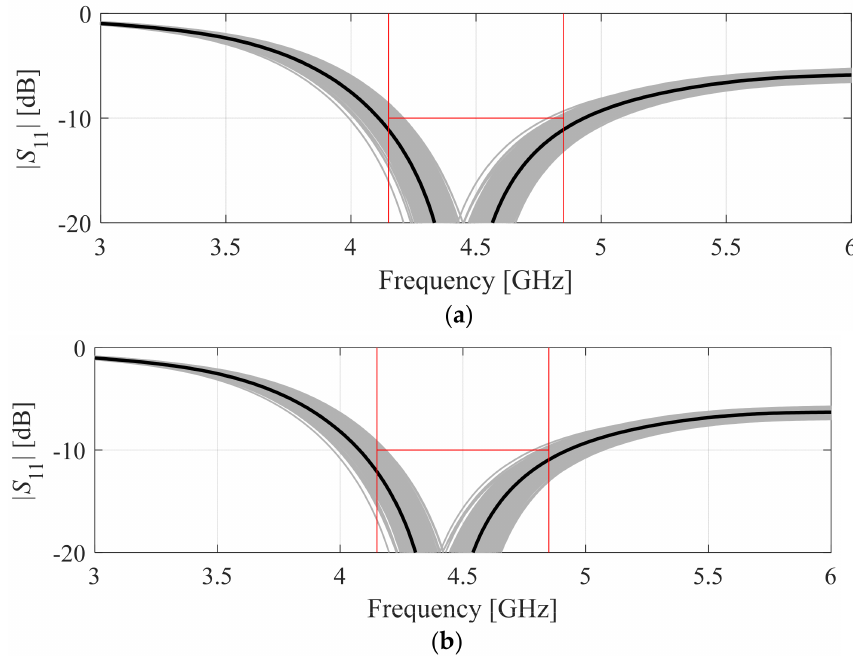
Figure 9. Monte Carlo analysis of antenna of Figure 7 using EM simulations (gray plots): ( a ) nominal design; ( b ) yield-optimized design obtained using the algorithm of Section 3.1. Black plots show the antenna response at the nominal and optimized designs, respectively.